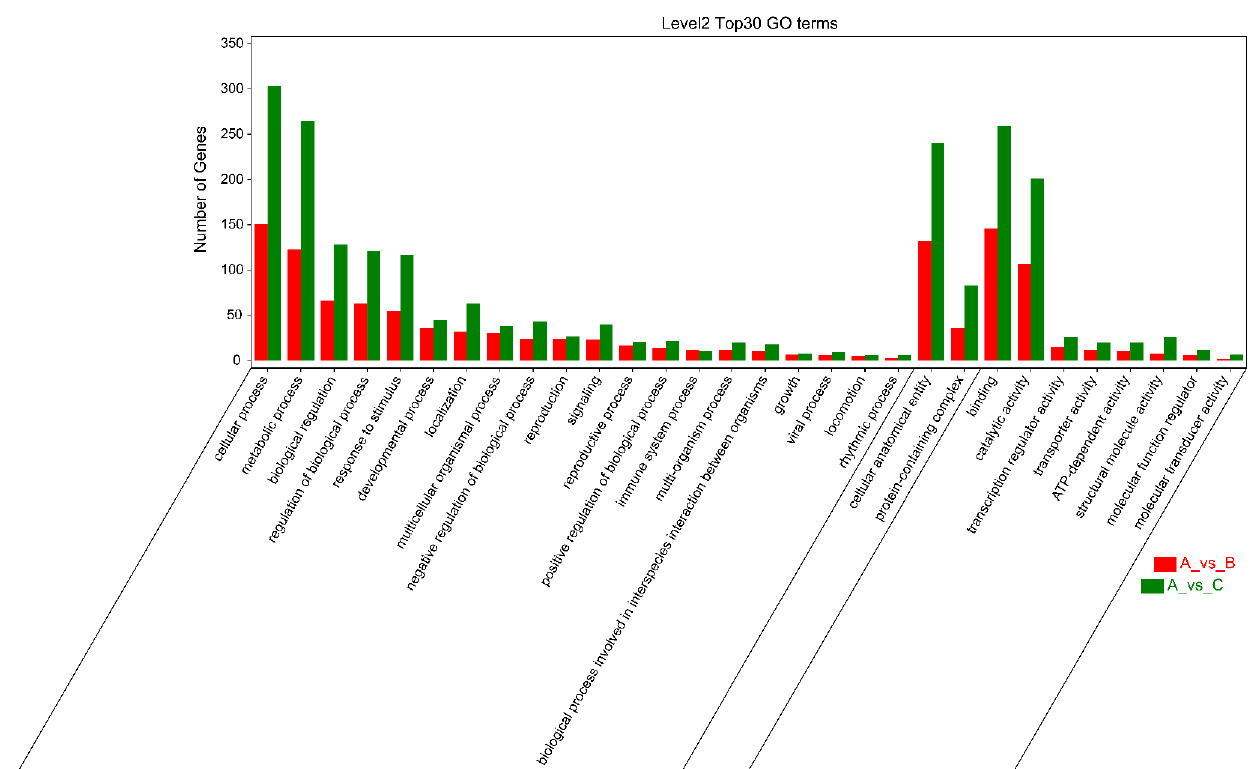
Figure 5. Genomic regions with selective sweep in P. wilsonii and P. likiangensis . B, P. wilsonii ; C, P. likiangensis .